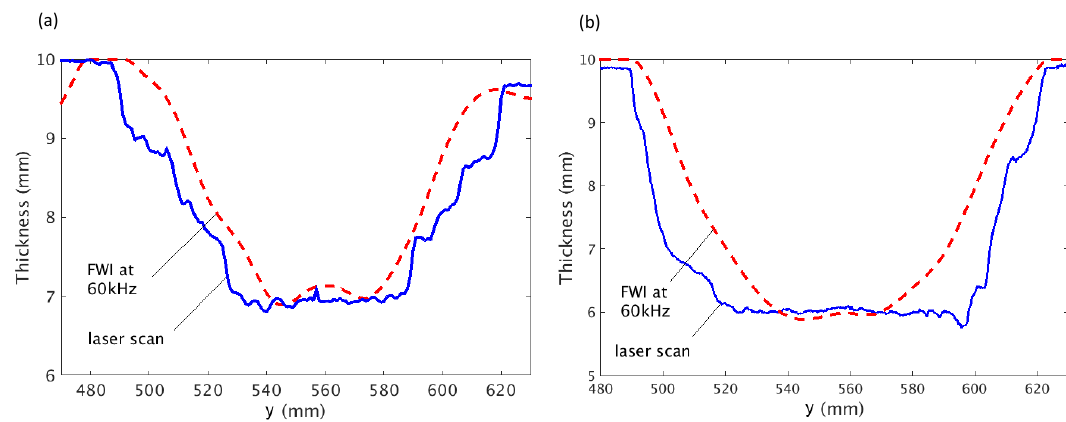
Figure 9. Cross sections of FWI reconstruction and laser measurement of ( a ) defect A and ( b ) defect B along the vertical